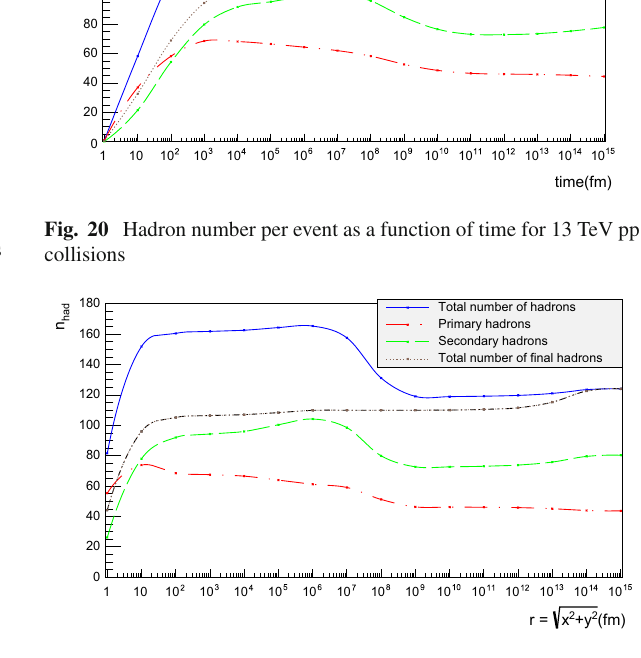
more, the expectation value of (cid:12) Γ (cid:13) = ( 1 + a )/ b ≈ 1 . 7 GeV 2 √ (cid:12) Γ (cid:13) /κ ≈ 1 . 3 fm, in agreement with Fig. 18. gives (cid:12) τ (cid:13) ≈